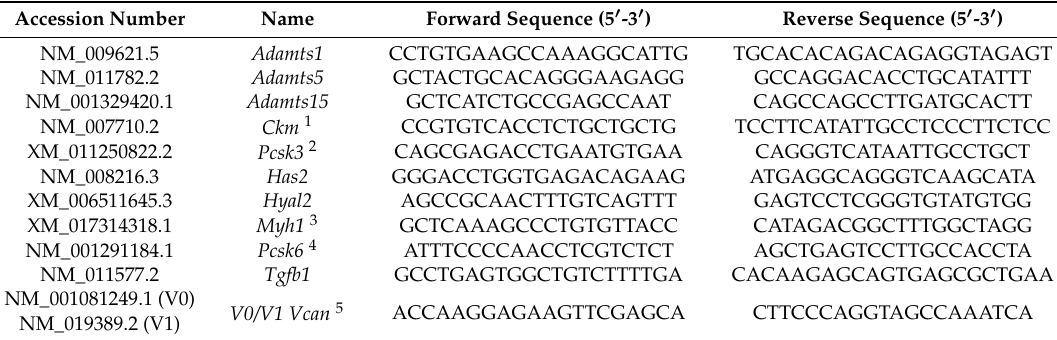
Table 1. List of primer sequences used for quantitative